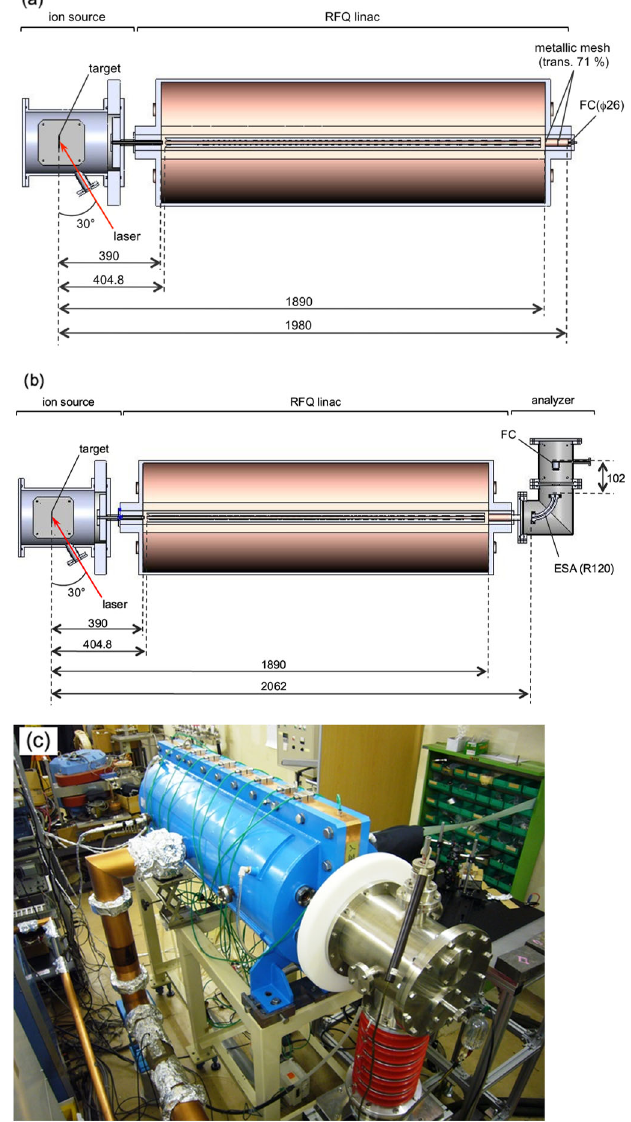
FIG. 29. Test apparatus for beam acceleration: (a) schematic drawing of a system for total output beam current measurement; (b) schematic drawing of a system to analyze the charge state of the ion beam; and (c) cover